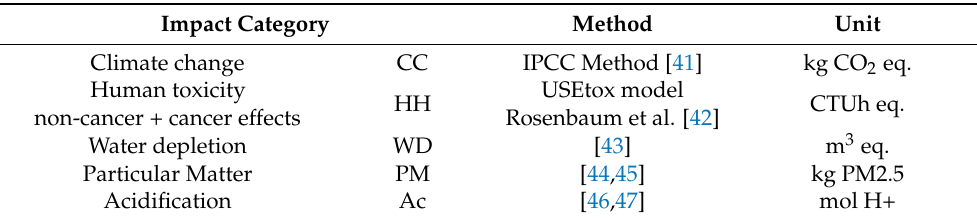
Table 1. Impact categories assessed in the study, abbreviates, methods, and